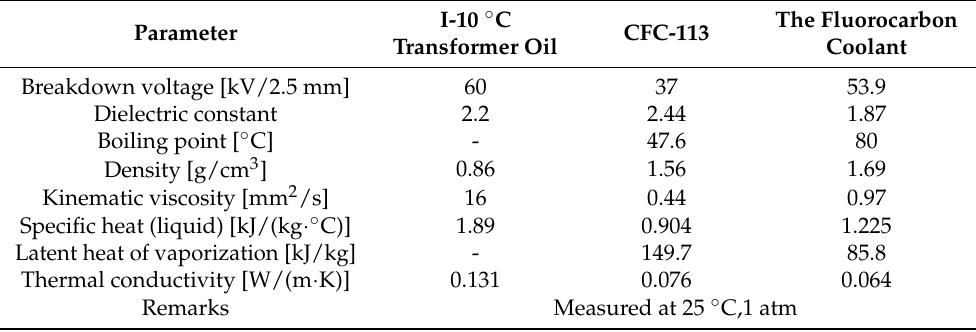
Table 1. Performance comparison of selected fluorocarbon coolant and other insulating coolant.